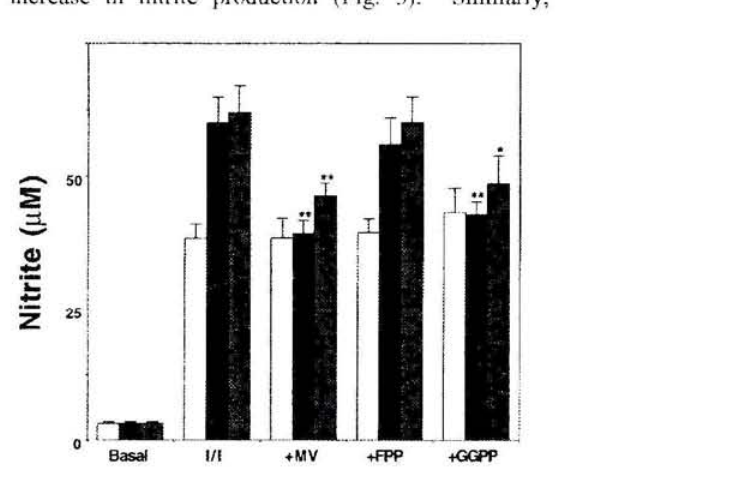
Κ fleet of mevalonate and isoprenoids on action of cervastatin or fluvastatin. Cells stimulated with IF-1/1FN plus cervastatin (5 μΜ, black bars) or fluvastatin (25 μΜ, gray bars) were incubated in the presence of mevalonate (MV, 0.1 mM), FPP (10 μΜ), or GGPP (10 μΜ) for 24 h then nitrite accumulation in culture media was measured. Data are means ±